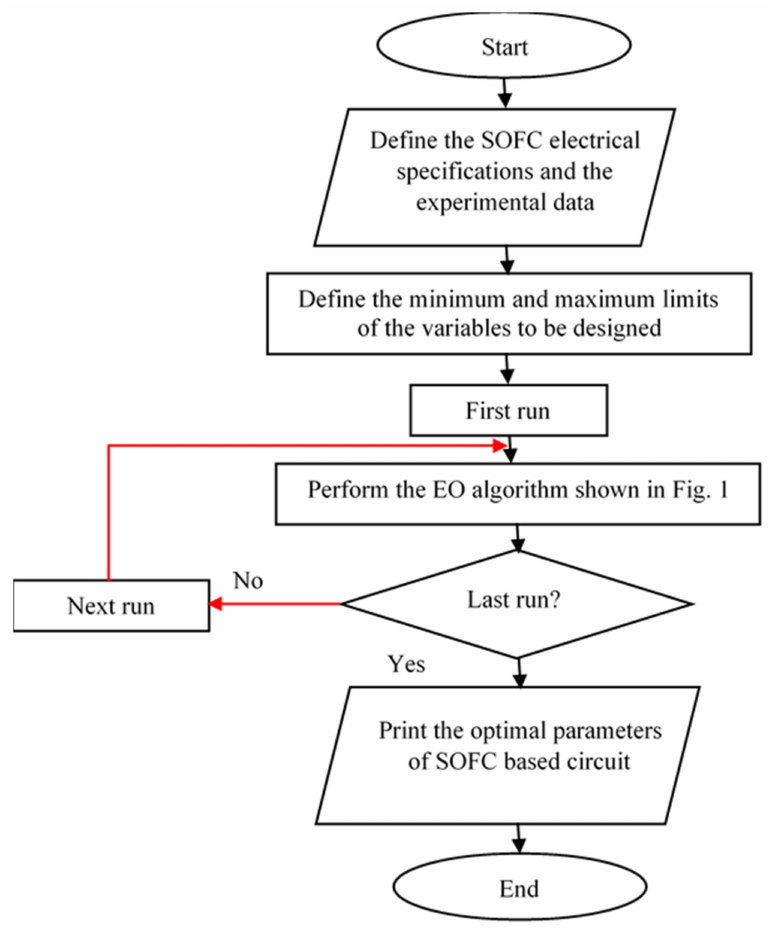
Figure 2. The proposed steps incorporating